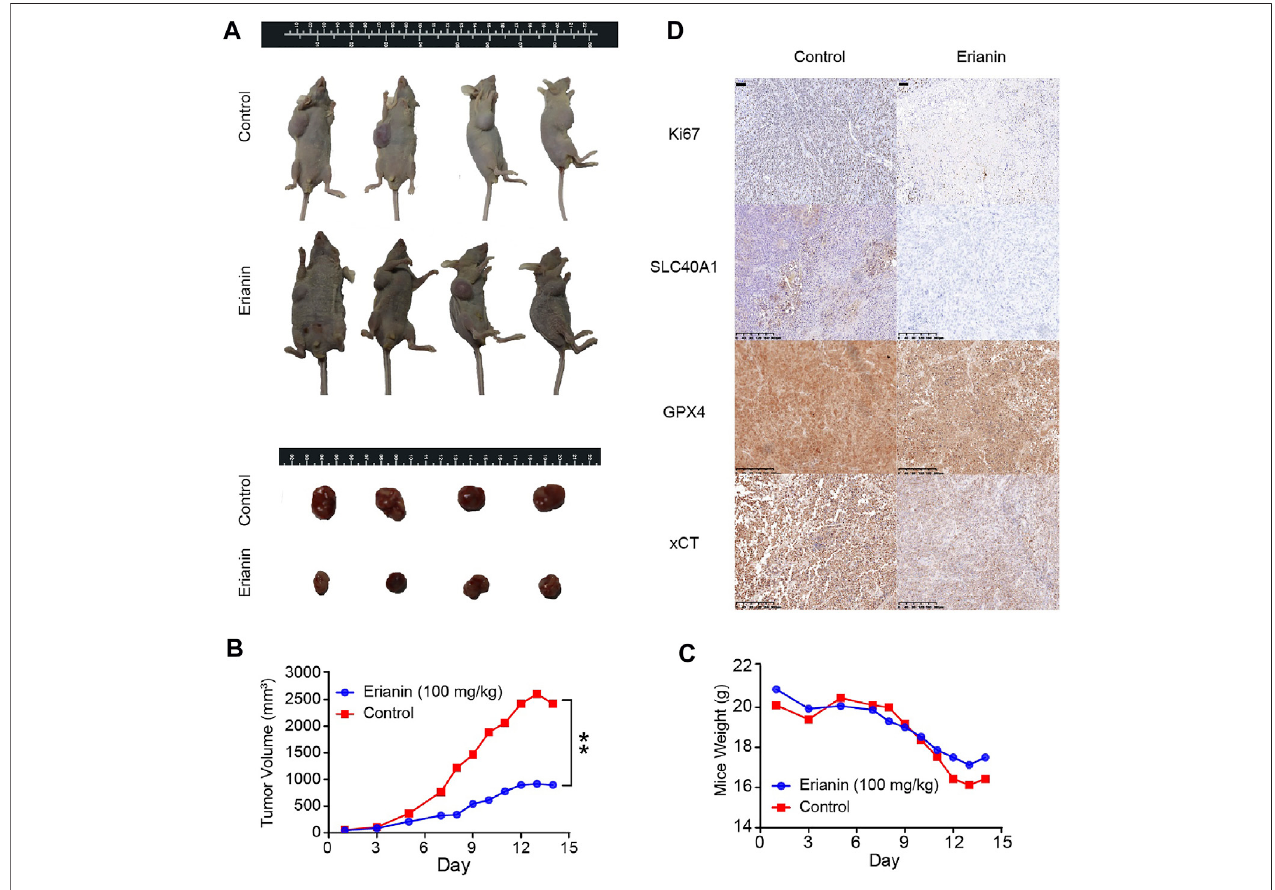
FIGURE4| Erianinsuppressedtumorgrowthbyinducingferroptosis invivo . (A) Representativeimageofmiceandxenografttumorsattheendpointofexperiment. (B) The average tumor volume from differentgroups. Values are shown as mean ± SD, ** p < 0.01. (C) The average mice weight from different groups. Values are shown as mean ± SD. (D) The expression of Ki67, GPX4, SLC40A1 and xCT were detected by IHC.